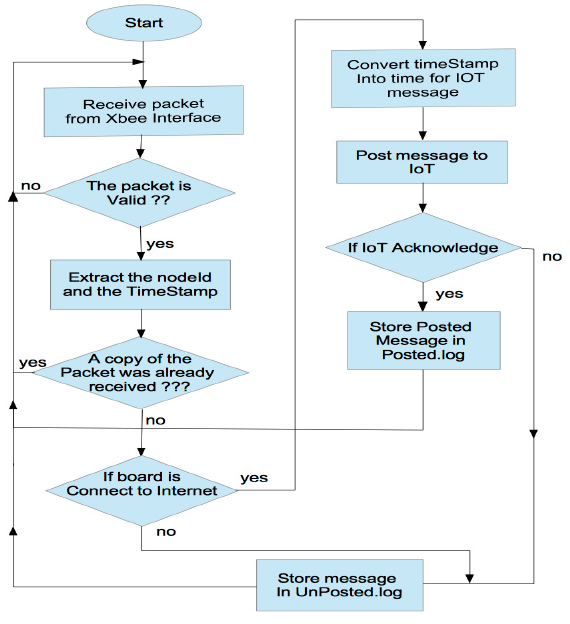
Figure 6. Flowchart of the data processing at the gateway.